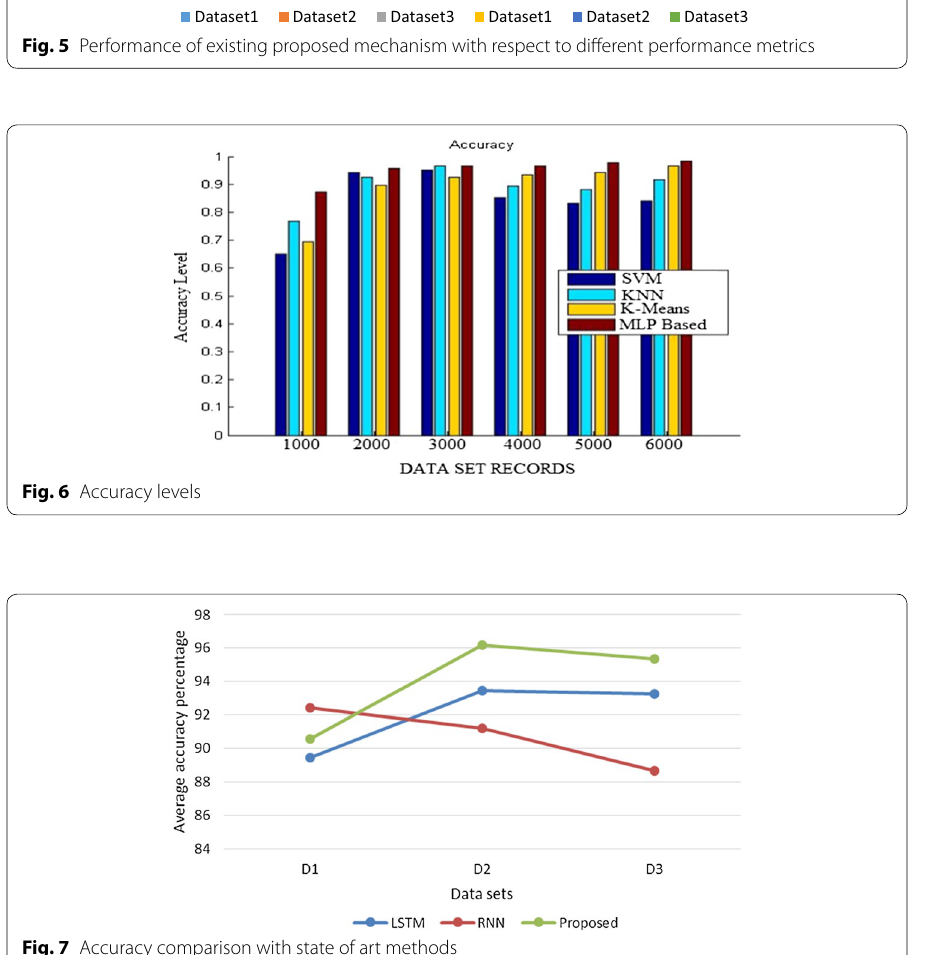
Fig. 7 Accuracy comparison with state of art